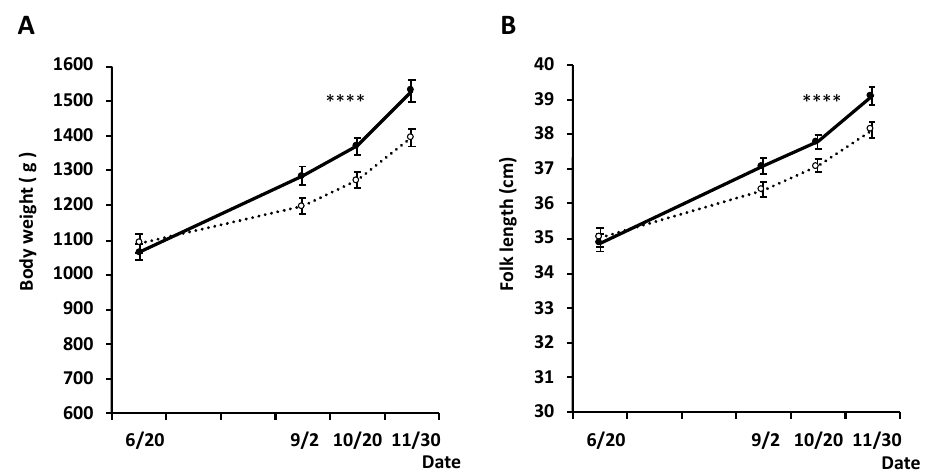
Figure 6. Effect of silkrose treatment on ( A ) sequential body weight and ( B ) fork length of white trevally at aquaculture field site. Solid line represents the results of silkrose-treated group, and dotted line represents results of control group. Results are presented as mean ± standard error. Asterisks indicate statistically significant differences compared with control group (**** p < 0.0001).